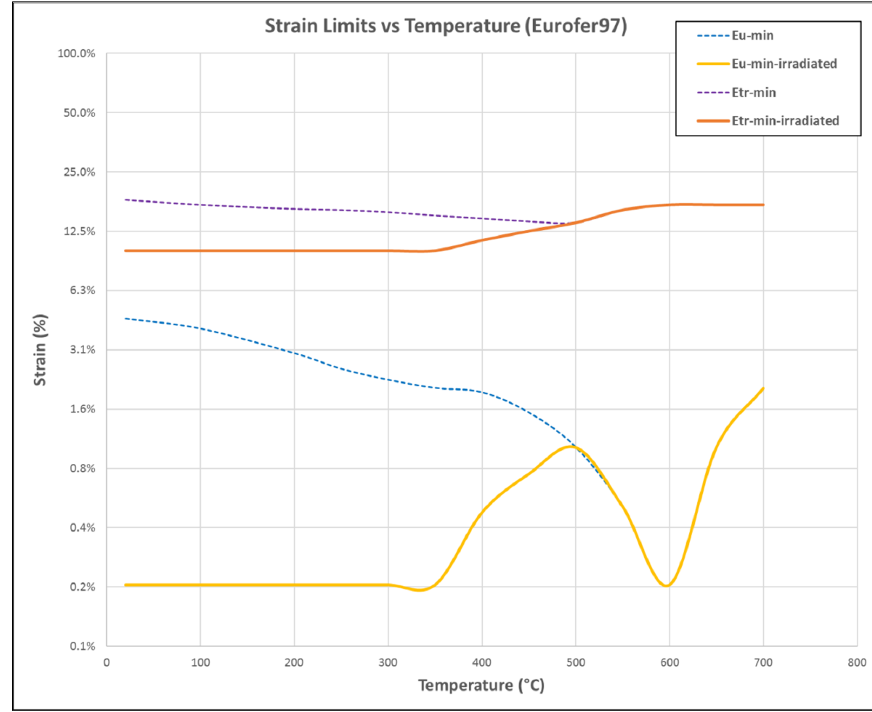
Figure 5. Strain limits with respect to temperature for Eurofer97 material.